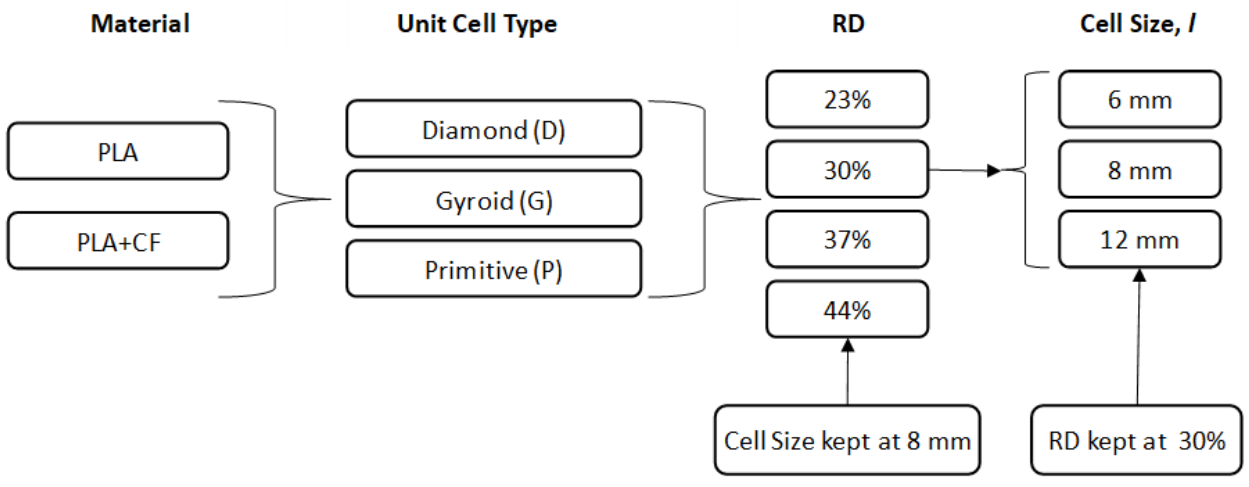
Figure 3. Investigation methodology.